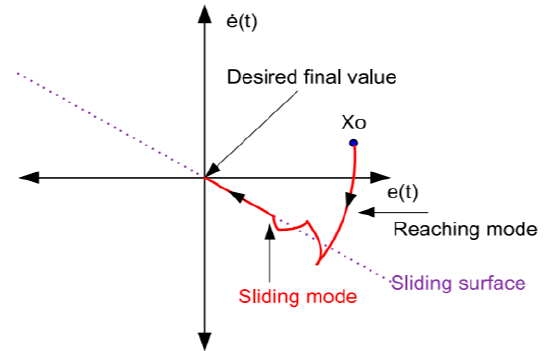
Figure 14. System trajectory of sliding mode controller (SMC) with sliding surface [90].